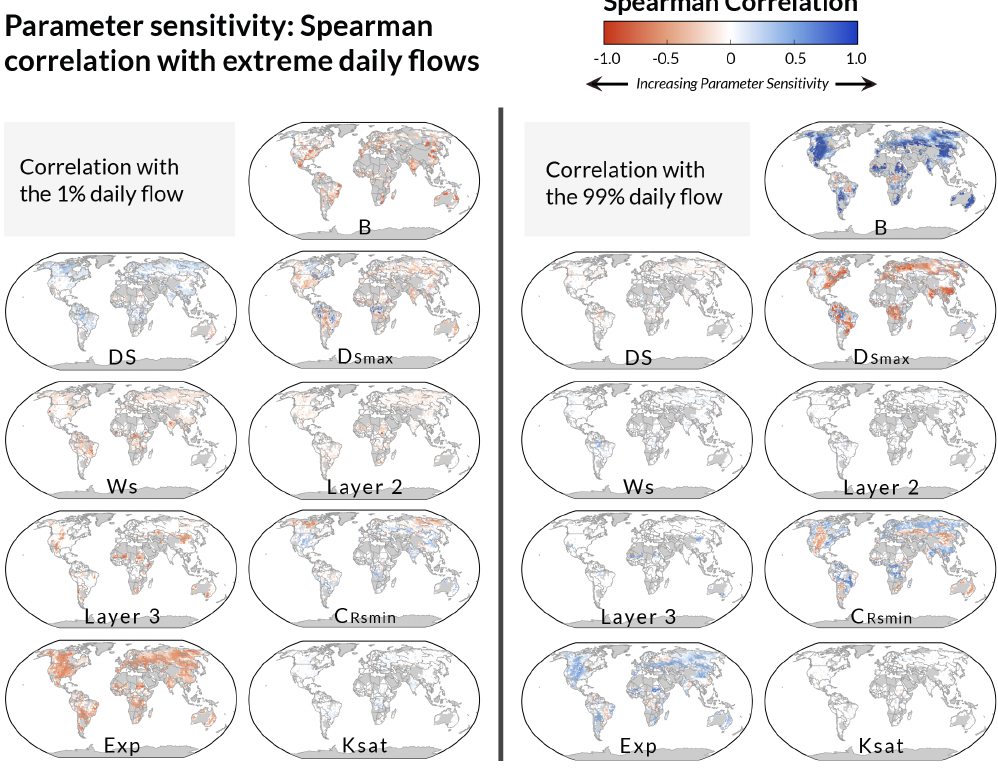
Figure 7. Global maps of the Spearman correlation between the simulated extreme daily flows (1st and 99th percentile) and the corresponding VIC parameter. The correlations are calculated using the ensemble members that fulfill the strongest error criteria (relative error below 10% and monthly correlation above